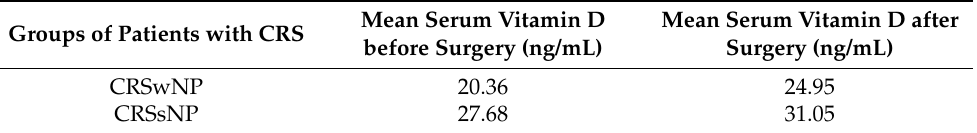
Table 5. Mean serum vitamin D before and one month after surgery (ng/mL) in patients suffering for chronic sinusitis with nasal polyps (CRSwNP) and those without nasal polyps (CRSsNP). Groups of Patients with